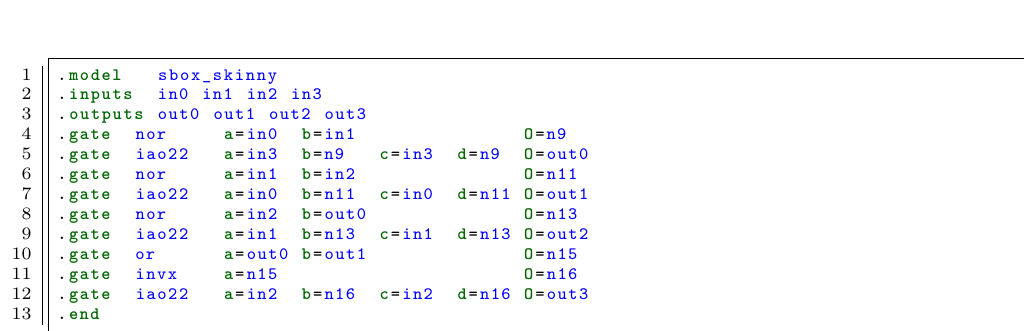
Figure 16: Combination of LIGHTER and ABC: Area-optimized hardware implementation of SKINNY Sbox using 13.00 GE with the standard cell library of the TSMC 65nm logic process.